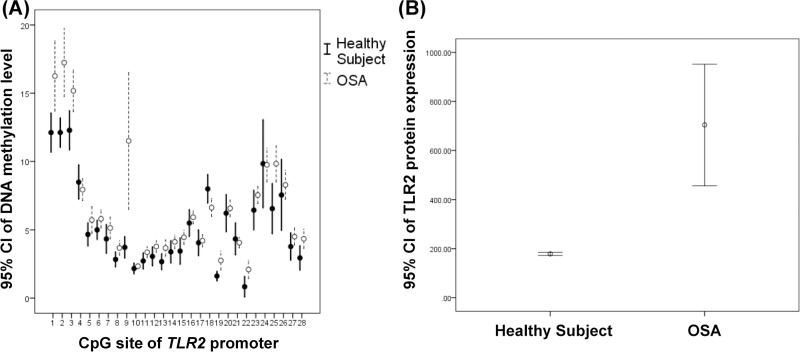
Comparisons of DNA methylation levels over the TLR2 promoter region and TLR2 protein expressions.(A)DNA methylation levels over CpG site #1, #2, #3, #8, #9, #13, #19, #22, #25 and #28 of the TLR2 promoter region were increased (p = .006, < .001, .006, .027, .003, .018, .004, .013, .005, and .015 respectively ), while DNA methylation levels over CpG site #18 of the TLR2 promoter region was decreased (p = .027). (B)TLR2 protein expression were increased in patients with severe OSA (p < .001).